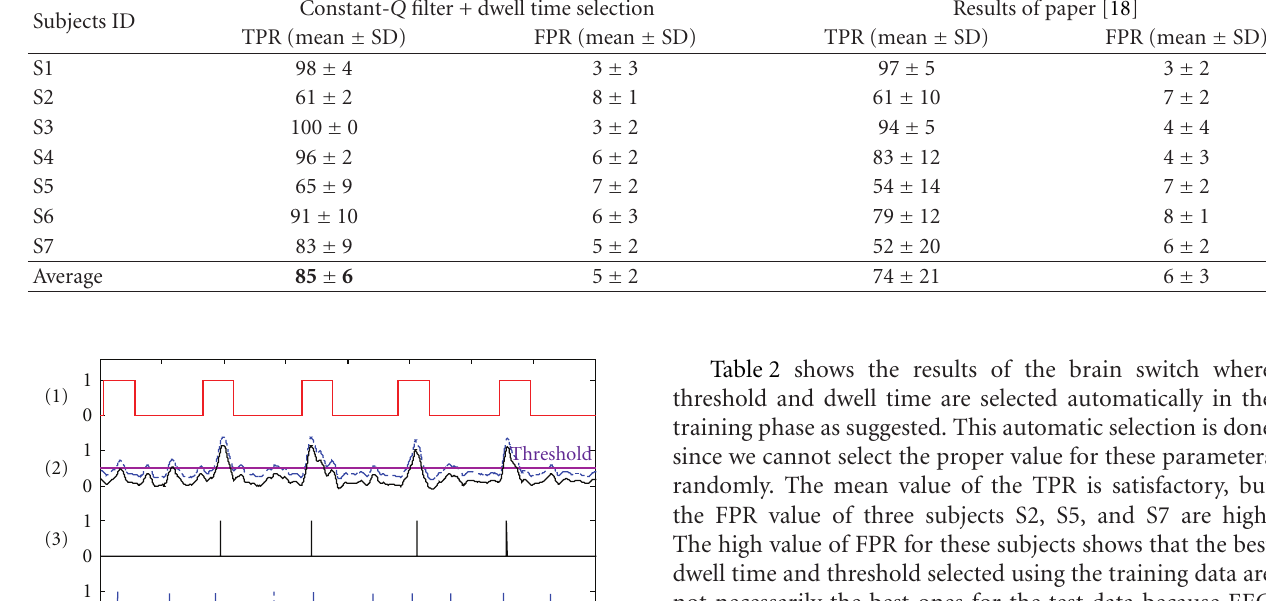
Table 4: Comparison of the results of this paper and results presented in [18]. Constant- Q filter + dwell time selection Subjects ID